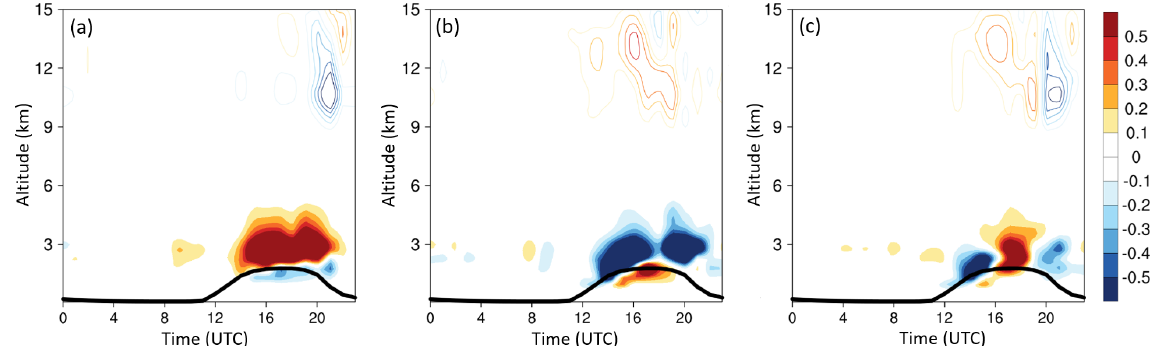
Figure 6. Diurnal variation in the vertical distribution of the domain-averaged difference in cloud water (shaded; in mgkg − 1 ) and cloud ice (contour lines; in 0.1mgkg − 1 ) caused by BB aerosols’ (a) ACI, (b) ARI, and (c) total effect in the EMIS1 emission scenario. The thick black line represents the PBL